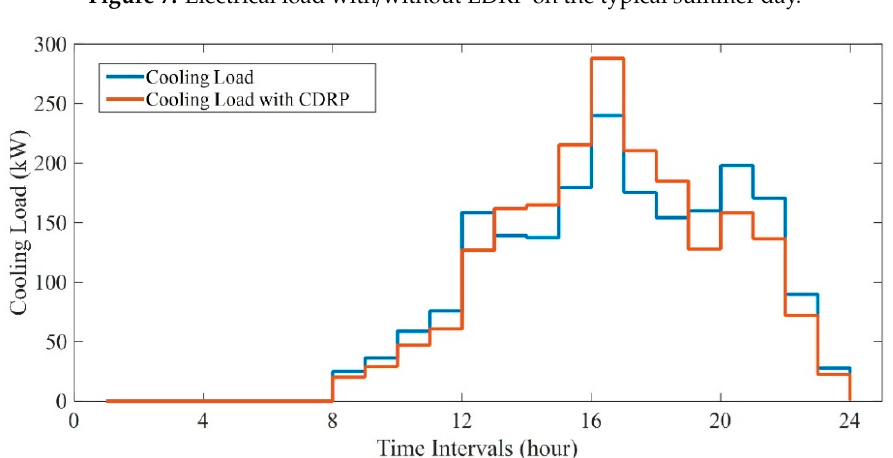
Figure 7. Electrical load with/without EDRP on the typical summer day.